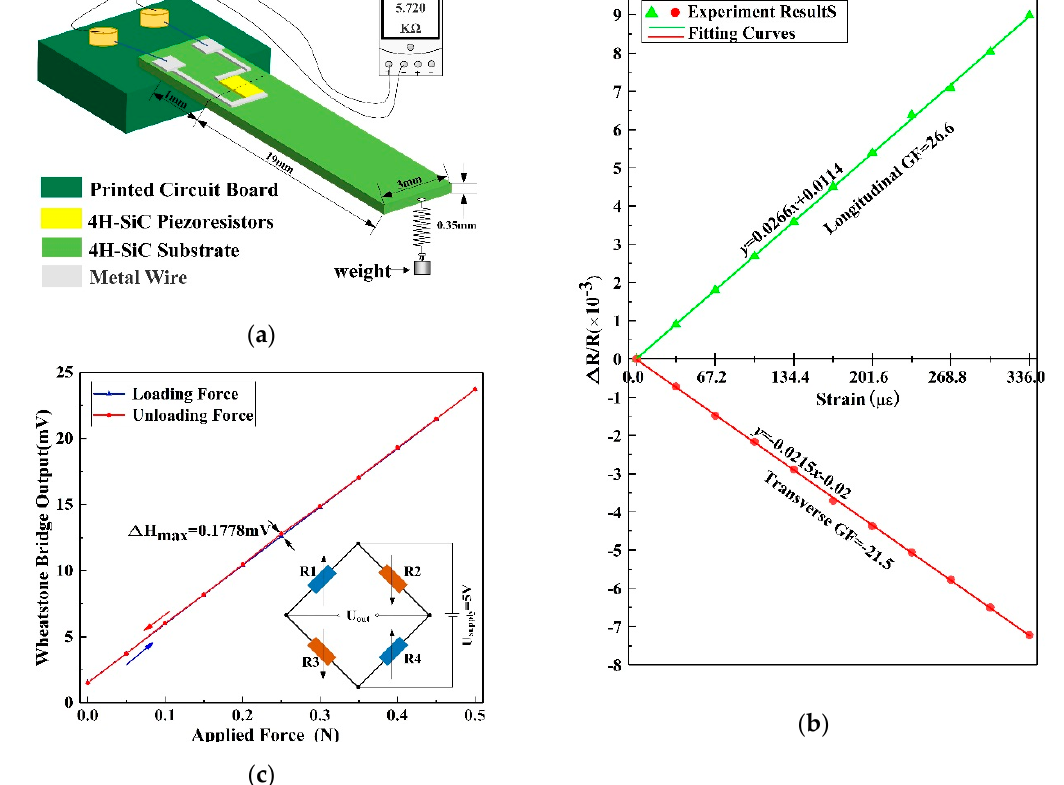
Figure 5. ( a ) Test structure of the p-type 4H-SiC piezoresistive effect. ( b ) The relative change in resistance ( ∆ R / R ) of the beams as a function of the strain. ( c ) Output voltage of the Wheatstone bridge as a function of applied load at room temperature ( R 1 , R 2 , R 3 , and R 4 are SiC piezoresistors on the beam, as shown in Figure 1a).